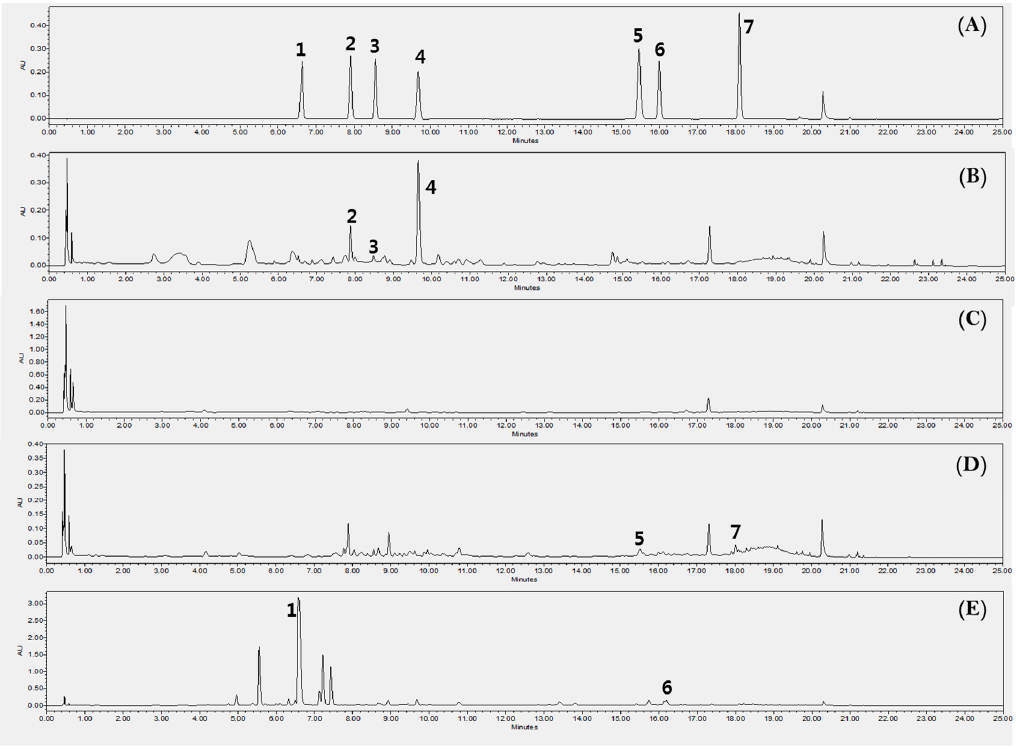
Figure 5. Ultra Performance Liquid Chromatography with Diode-Array Detection (UPLC-DAD) chromatogram for the quantification of the compounds 1–7 in each extract of the part of kudzu at 245 nm. A BEH column (Waters, USA), C18 (2.1 ⅹ 100 mm i.d.; 1.7 μ m) was used. The gradient program